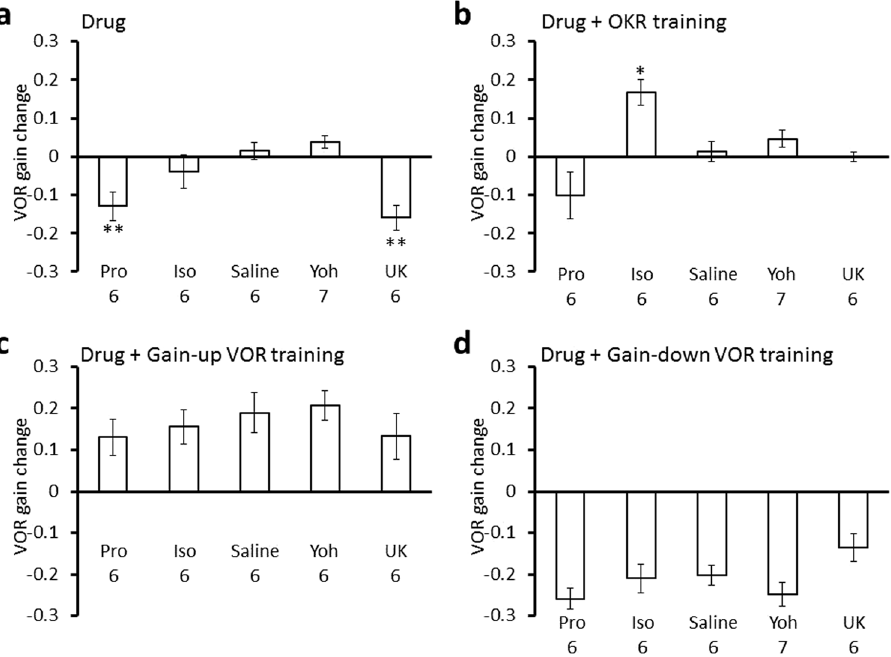
Figure 6. VOR gain changes induced by various treatments. ( a ) Effects of administration of propranolol (Pro), isoproterenol (Iso), saline, yohimbine (Yoh) or UK14304 (UK) on the VOR gain. Pro, Iso and Saline data are same as those shown in Fig. 2h. They are presented again for comparison. ( b–d ) Effects of administration of propranolol, isoproterenol, saline, yohimbine or UK14304 on the VOR gain changes induced by OKR training ( b ), by gain-up VOR training ( c ) or by gain-down VOR training ( d ). Numbers under each graph indicate numbers of mice, and error bars indicate SEM. * p < 0.05, ** p < 0.01, compared with saline-injected control, Dunnett’s